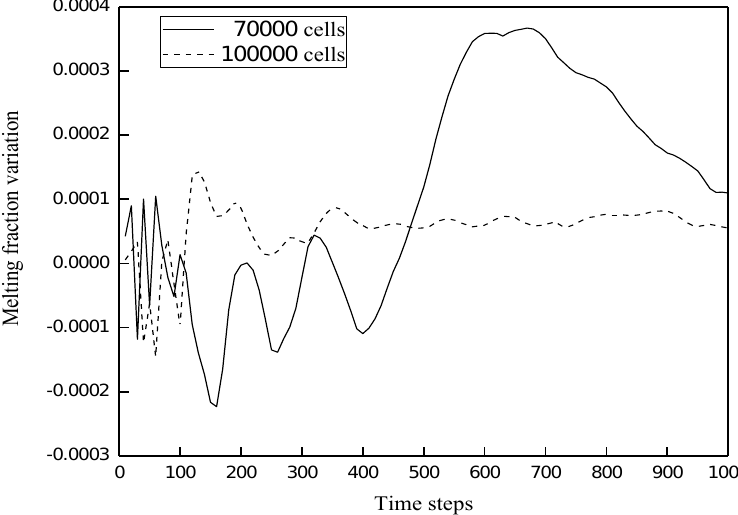
Figure 4. Melting fraction variation as a function of time for the examined node densities used in the computational solution. computational